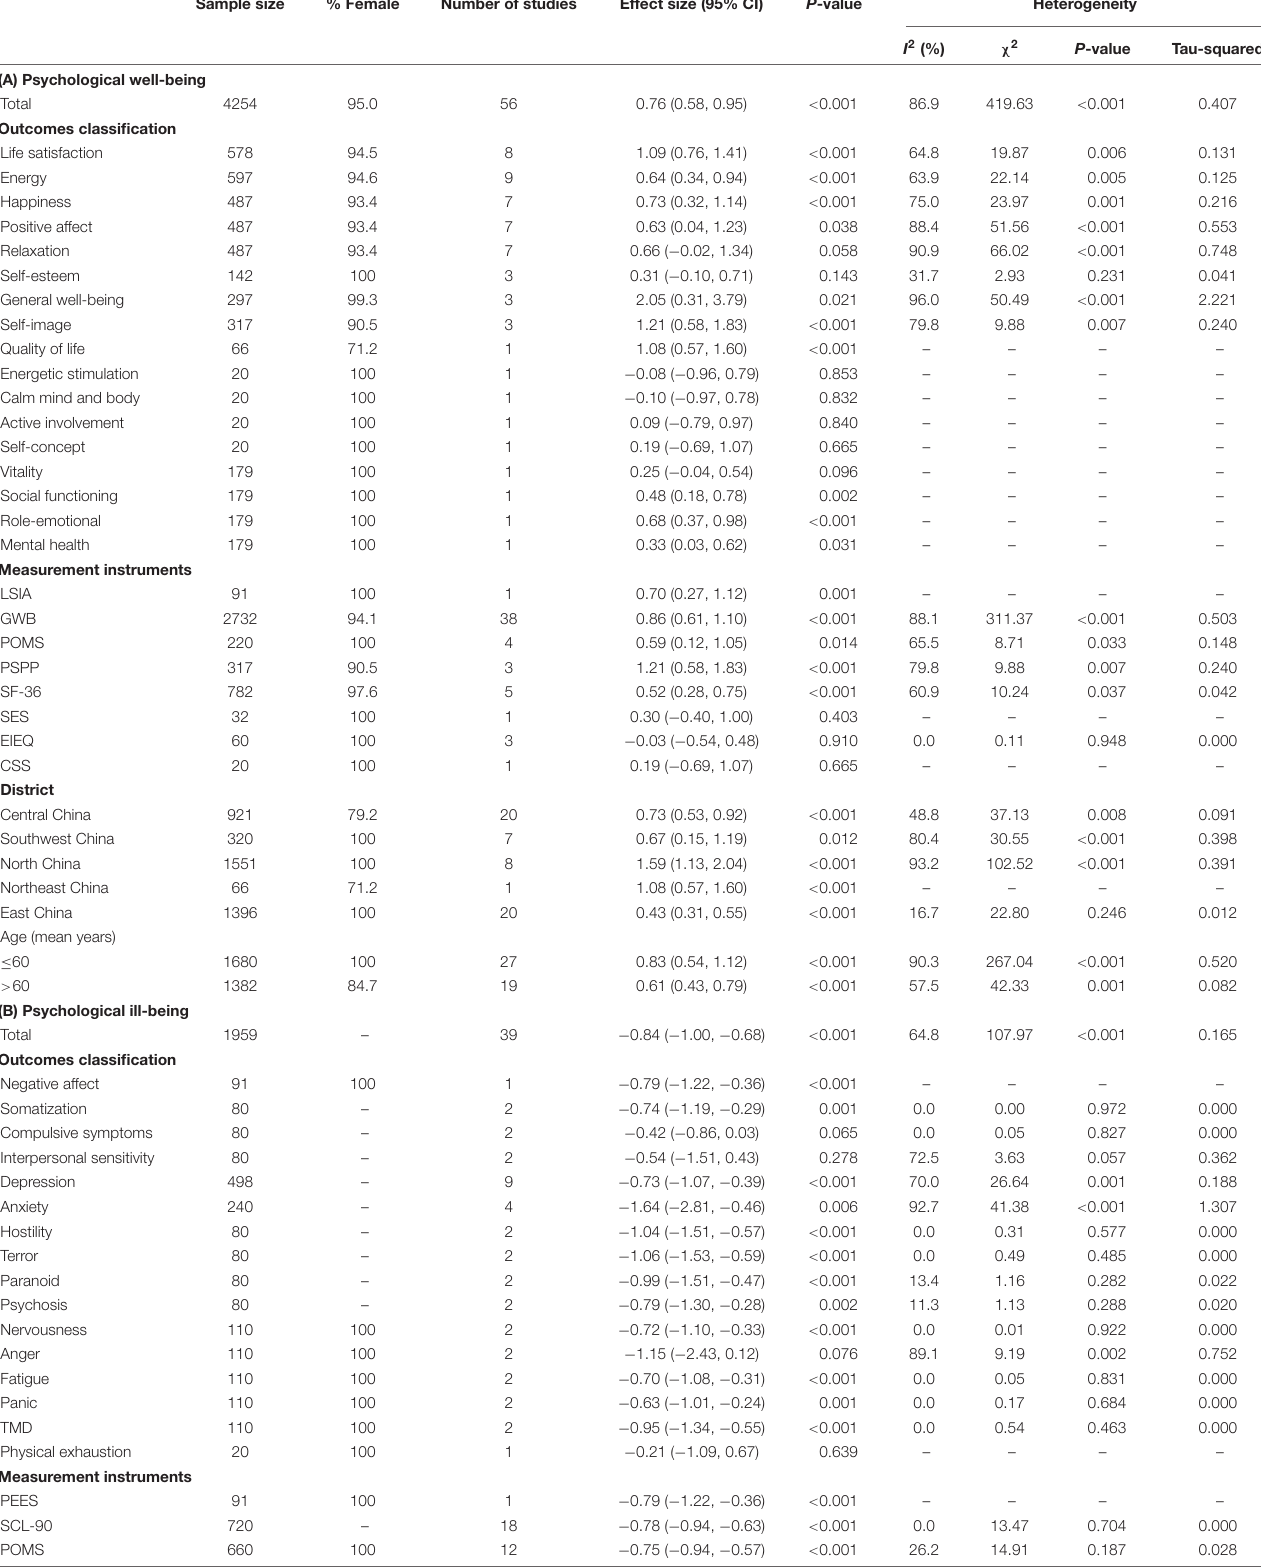
TABLE 2 | Overall and subgroup meta-analyses of the effectiveness of plaza dancing on psychological well-being and ill-being. Sample